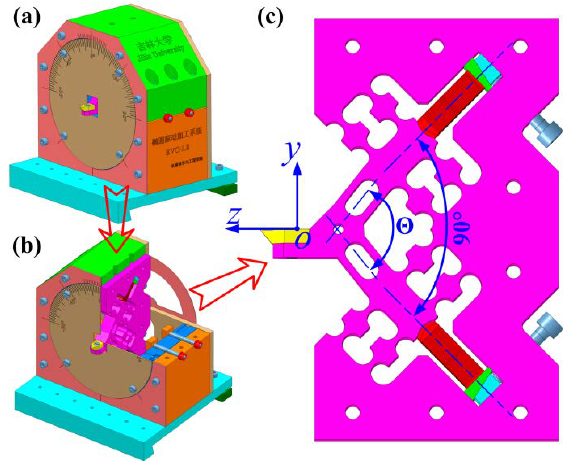
Figure 9. The 3D model of the ( a ) EVC system and ( b ) its sectional view, as well as the ( c ) modified 2-DOF PDCM.